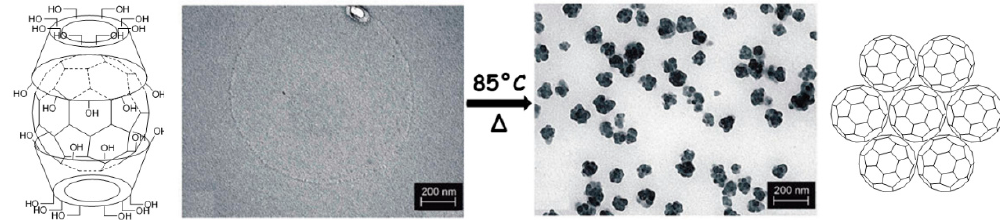
Figure 72. Visual and TEM images of C 60 - γ -CD and C 60 aggregates after 150 min of heating at 85 °C . Reproduced and adapted by permission of The American Chemical Society [221].